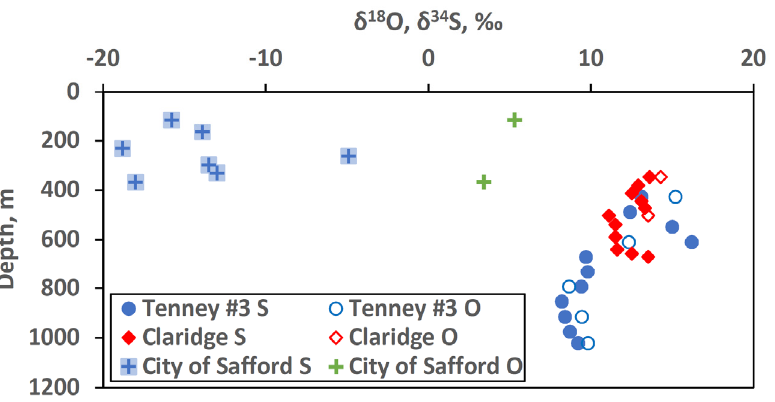
Figure 6. Values of δ 34 S and δ 18 O (sulfate) in drill-cuttings from Safford Basin, as a function of depth below surface.